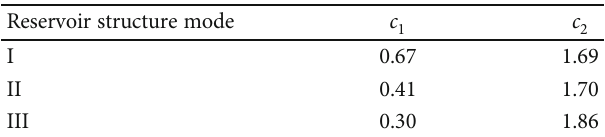
Table 4: The constant parameters c oil fi